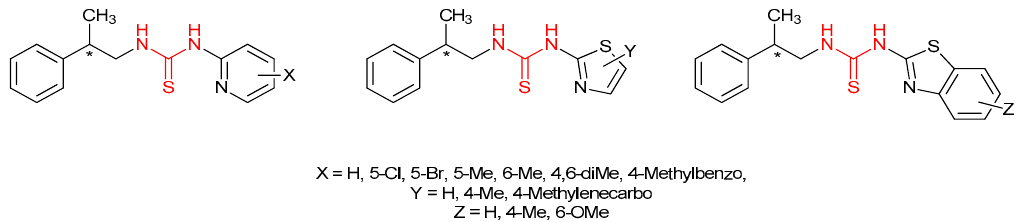
Figure 39. Chiral thioureas studied by Vankatachalam and co-workers as antiviral agents [372].